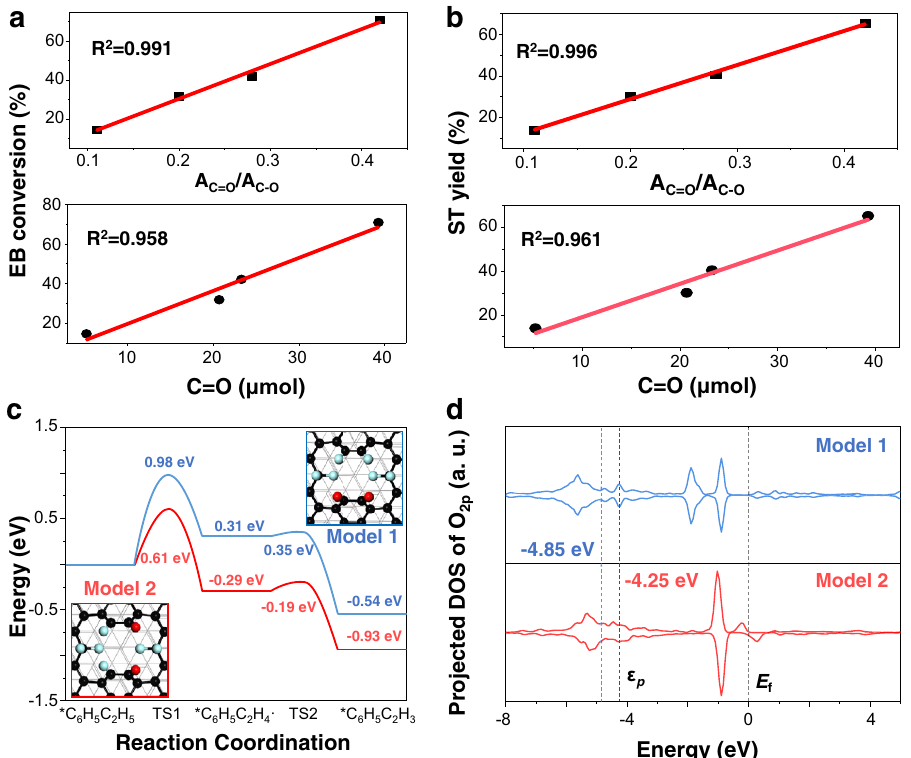
Fig. 4 The origin of active centre and proposed reaction mechanism of EB dehydrogenation over F-ND catalysts. a Linear fi tting of EB conversion of A C = O /A C − O and mole of C = O, respectively. b Linear fi tting of the ST yield of A C = O /A C − O and mole of C = O, respectively. c DFT calculated reaction pathways of EB dehydrogenation on F-ND catalysts with two C = O groups without (Model 1, blue curve) and with (Model 2, red curve) an F atom located at an adjacent carbon atom to C = O. colour scheme: C in the outmost graphene surface, black; other C atoms, grey; O, red; F, light blue. d Projected density of states (PDOSs) of O 2 p states in C = O groups without (upper panel) and with (lower panel) an F located at an adjacent carbon atom to C = O. The corresponding p -band centre was highlighted with the Fermi level ( E F ) set to zero. TS transition